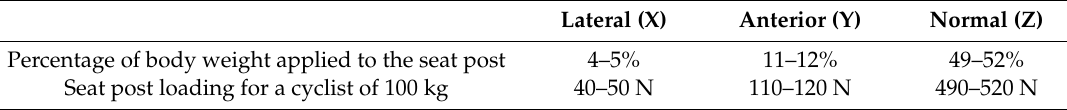
Table 1. Seat post loading during